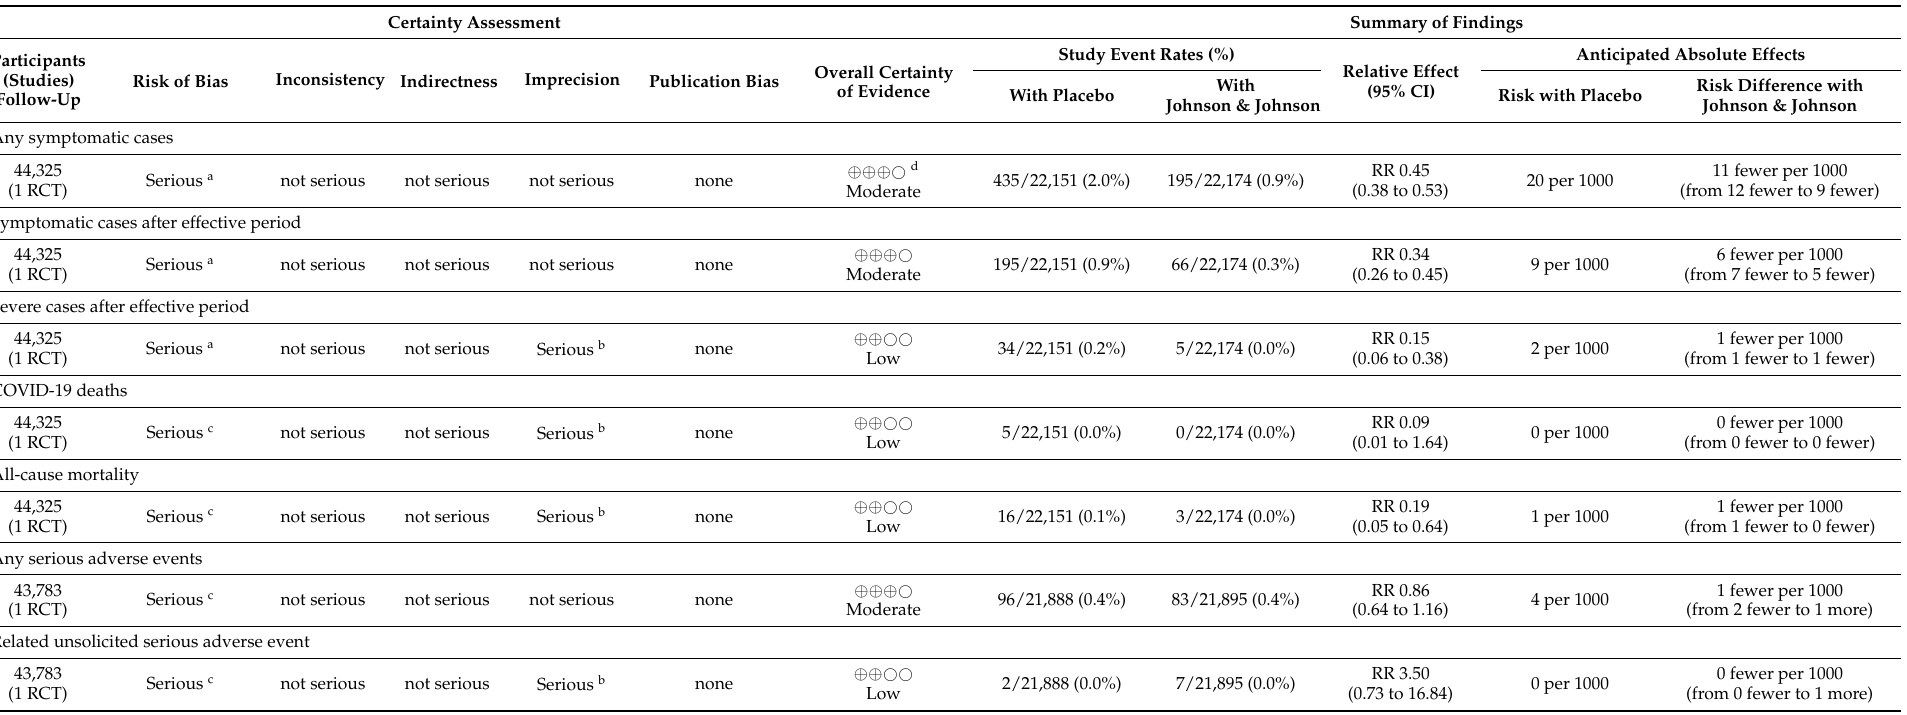
Table 3. GRADE evidence profile denoting the benefits and risks associated with Johnson & Johnson vaccine for the prevention of COVID-19 in adults. The table includes relative and absolute effects along with the overall certainty of the